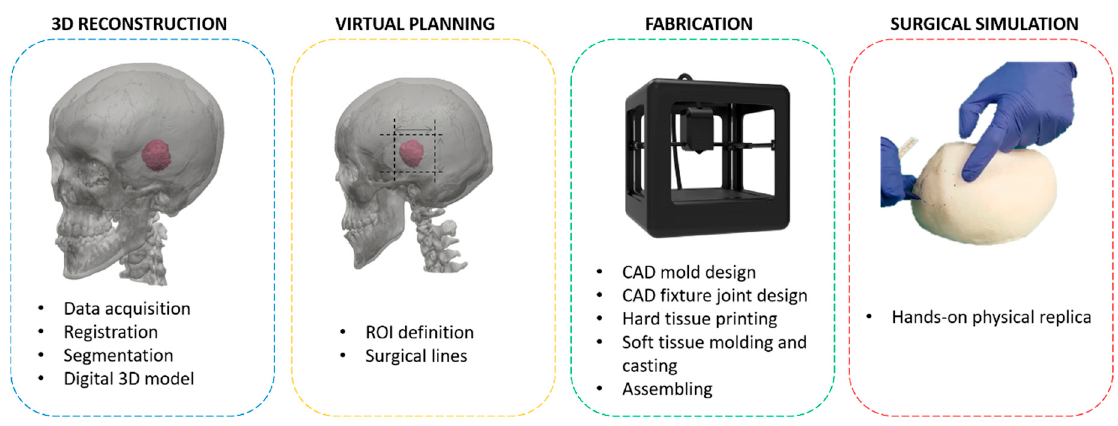
Figure 2. Simulation process pipeline.